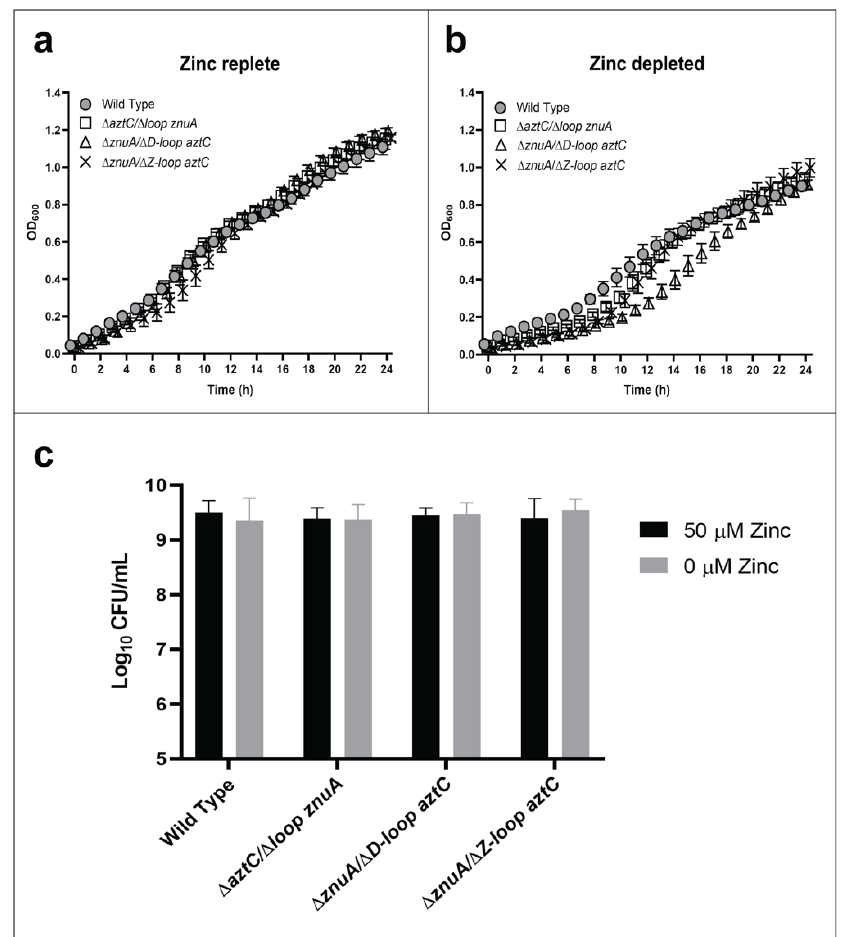
Figure 3. Flexible loop structures are not essential for zinc transport. Growth curves at 600 nm in zinc-replete ( a ) or zinc-depleted ( b ) conditions for 24 h. Cellular viability quantification after 48 h of incubation ( c ). Error bars represent the mean ± S.D. of triplicate experiments. For the CFU, two-way ANOVA was used followed by Tukey’s multiple comparison test to show that there was no statistically significant difference in viability between the mutants and WT.